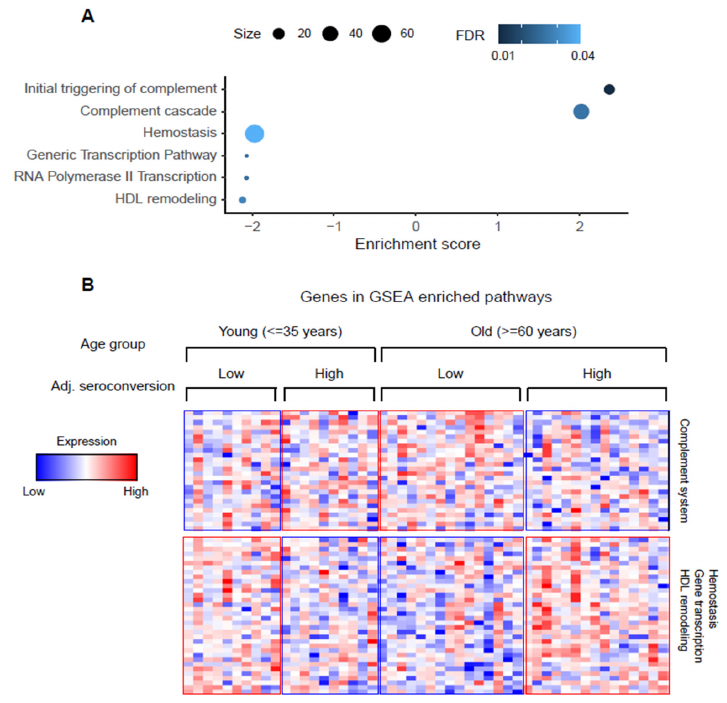
Figure 3. Genes of the complement system, HDL remodeling, transcription, and hemostasis have complex relationships with adjusted seroconversion and age of the vaccine recipient. ( A ) Gene functional pathways that are significantly enriched in the age & adjusted seroconversion two-way ANOVA (see Methods). ( B ) Levels of the proteins from the significantly enriched pathways. Adj. seroconversion, adjusted seroconversion.